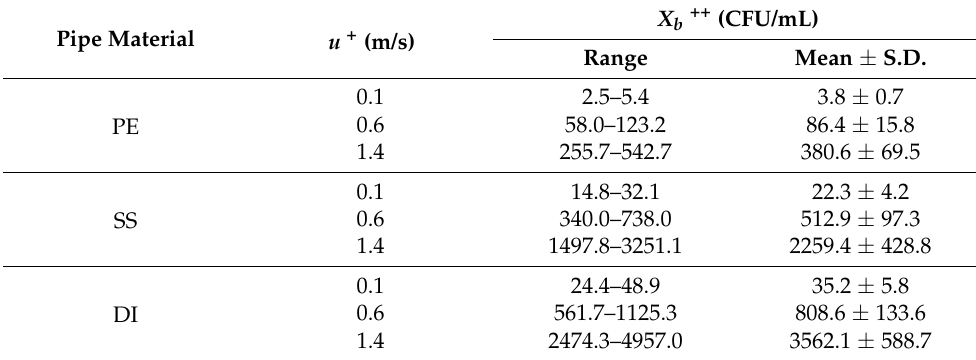
Table 1. Estimated planktonic microbial cell counts inside the pipe loops at 20 ◦ C under non- chlorinated